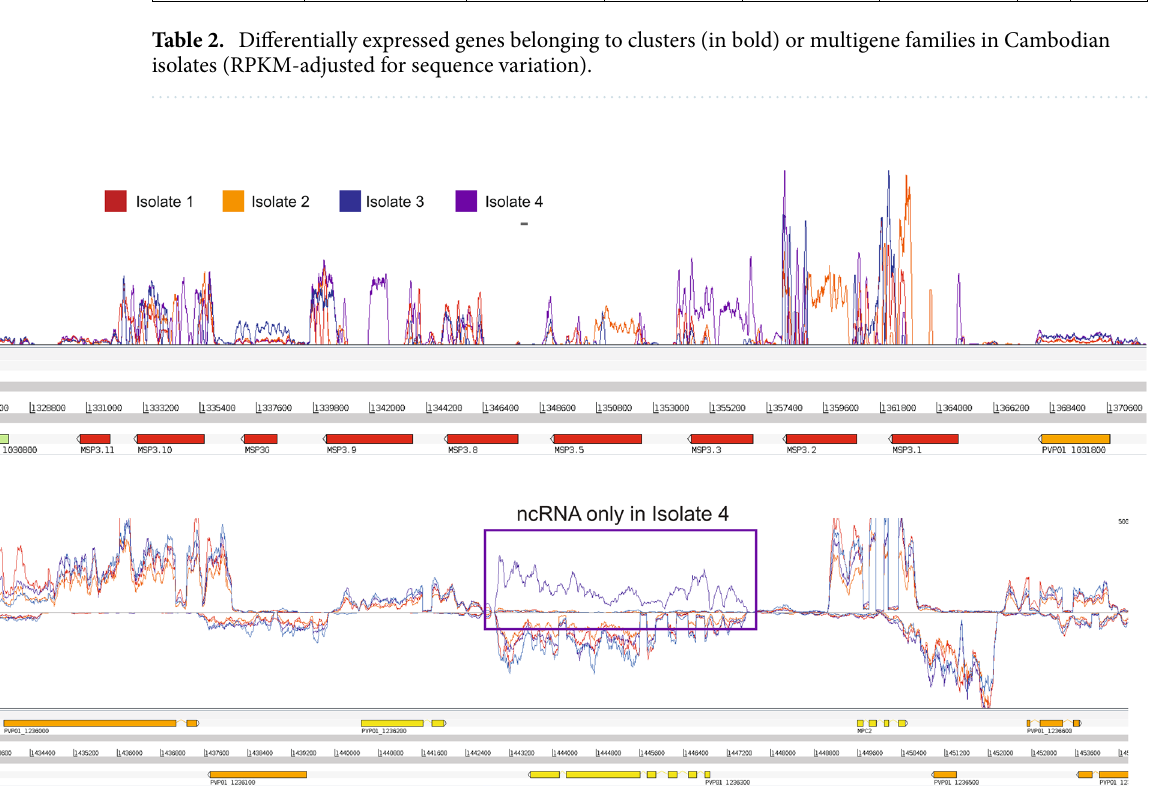
Figure 3. Variation in RNA-seq data between the four patient isolates. ( a ) RNA-seq coverage data (lines in top panel) for the region on PvP01 chromosome 10, which contains the sequences of multiple MSP3 genes (shown in red on the lower panel). Levels of transcripts detected for each of the genes in this locus vary between each of the patient isolate (see key in figure to identify traces). Drops in coverage within an annotated gene model are likely to represent sequence divergence in the patient isolates from the reference genome. ( b ) RNA-seq coverage data (lines in top panel) for a region of PvP01 chromosome 10. The four patient isolates show very similar transcript levels for most of the protein coding genes in this region. However, an unannotated ncRNA (highlighted by a box) was only found in isolate 4, opposite to the gene